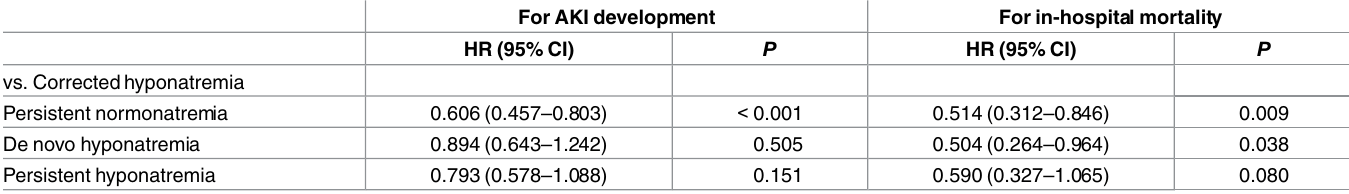
Table 5. Hazard ratioof hyponatremia correctiongroup for the development of acutekidney injuryand in-hospitalmortality in multivariate Cox proportional hazard regression